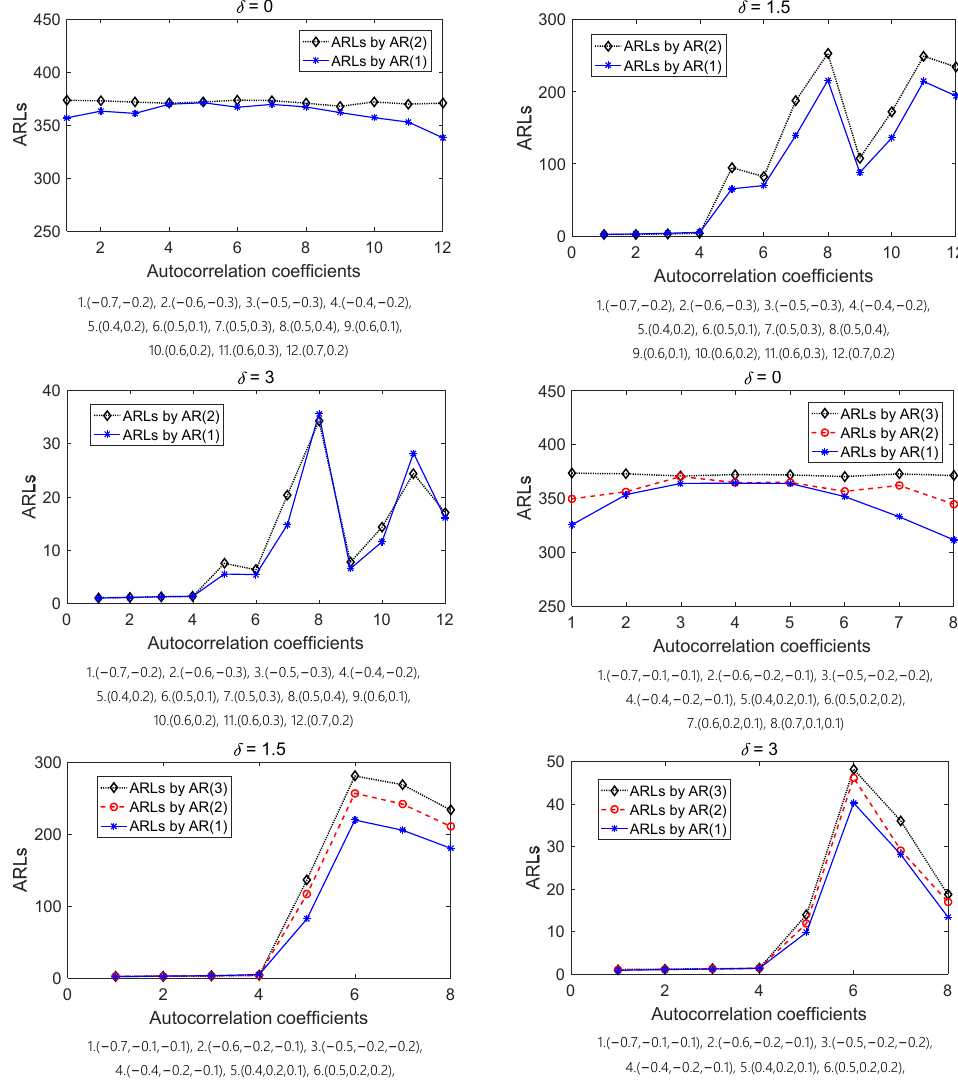
Figure 1. The ARL results of the order selection experiment.